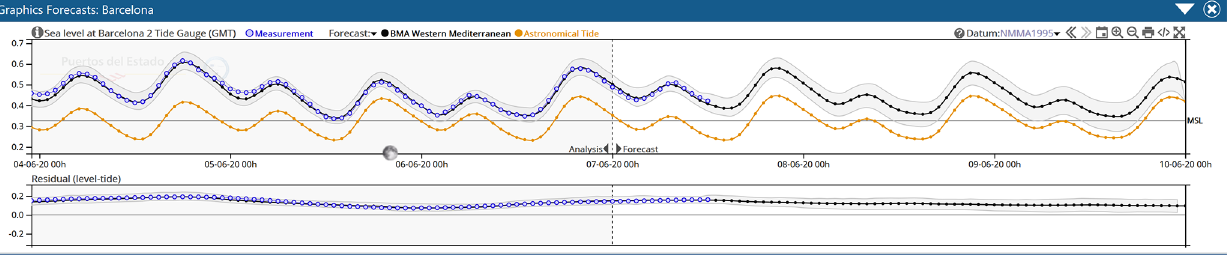
Figure 3. Sea level forecasted at Barcelona on 7 June 2020 (hourly time series): black: BMA solution (shaded area: 95% uncertainty band based on the output of the different models); blue: tide gauge observations; orange: tide. The BMA solution is obtained by combining the sea level solutions from IBI-MFC, MED-MFC and Nivmar at Barcelona harbor (as displayed in PdE Portus system: https://portus.puertos.es, last access: June 2021).